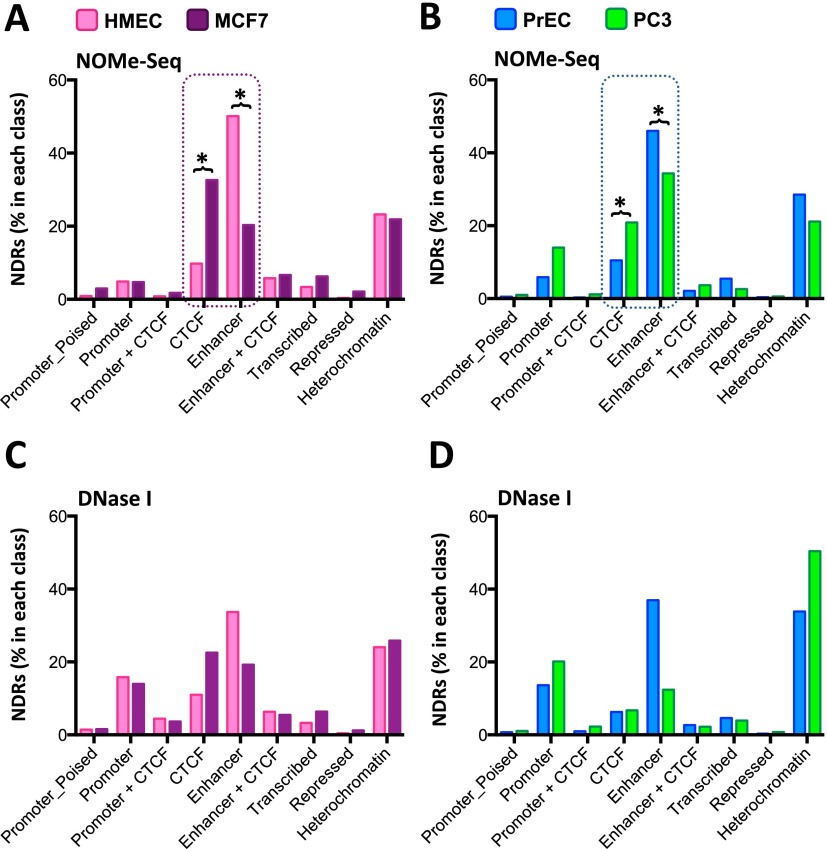
NDRs are enriched at enhancers in normal epithelial cells and change to predominantly overlap CTCF in cancer cells. (A,B) ChIP assays were performed with antibodies detecting RNA Pol II-P, H3K4me3, H3K27ac, H3K4me1, and H3K27me3 on chromatin from HMEC, MCF7, PrEC, and PC3 cells. ChIP-seq data for CTCF was generated (PC3) or obtained from ENCODE. ChIP-seq chromatin states were classified using the ChromHMM hidden Markov model (Ernst and Kellis 2012). Data are presented as percentage of NDRs detected by NOMe-seq in each of nine chromatin states (heterochromatin, repressed, transcribed, enhancer, enhancer + CTCF, CTCF, promoter + CTCF, promoter, promoter_poised) (y-axis) for HMEC (pink bars), MCF7 (purple bars), PrEC (blue bars), and PC3 (green bars). (C,D) As for A and B using DNase I hypersensitivity data as the measure of accessibility (percentage of NDRs in each class).